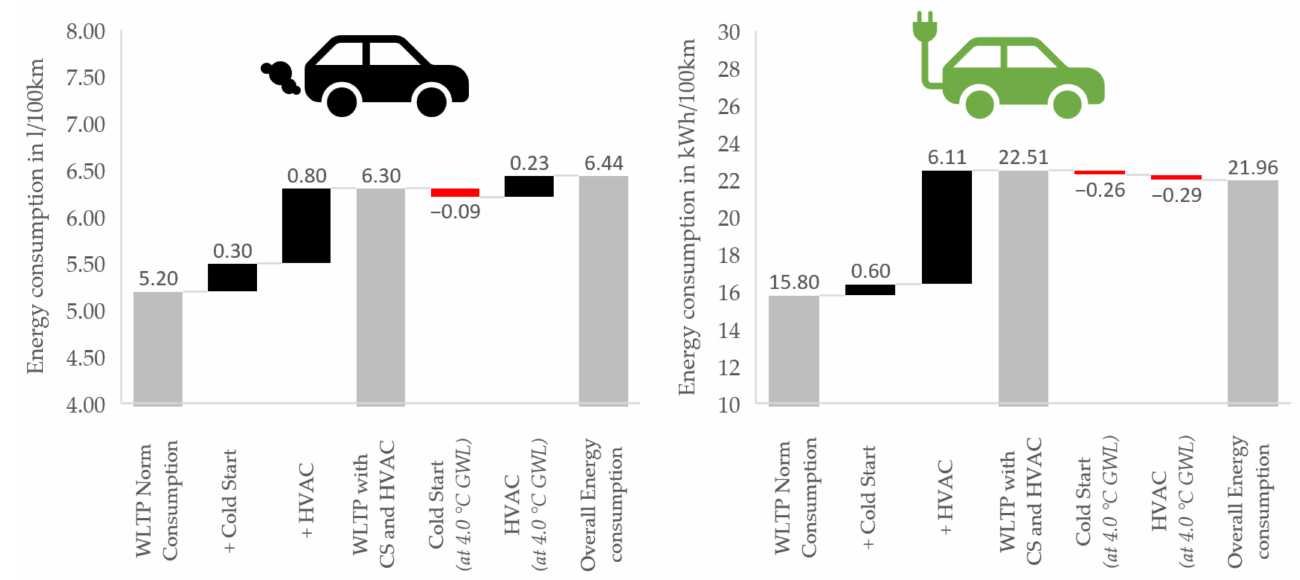
Figure 5. Average annual energy consumption of a VW Golf 1.0l eTSI ( left ) and a VW eGolf ( right ) compared to the average calculated energy consumption at 4.0 ◦ C global warming level (GWL) based on the MiD Dataset.